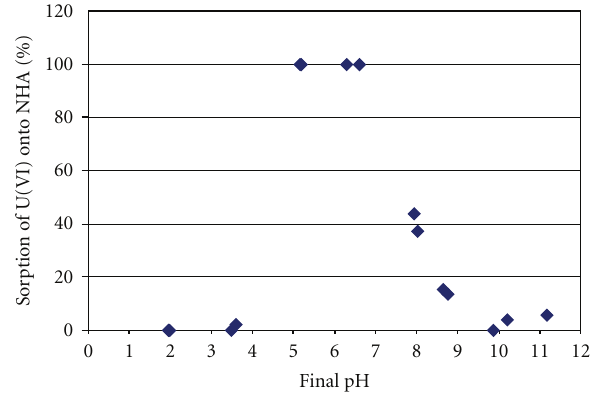
Figure 4: Influence of pH on U(VI) removal by synthetic NHA; experimental conditions: U(VI): 1mg/L and NHA: